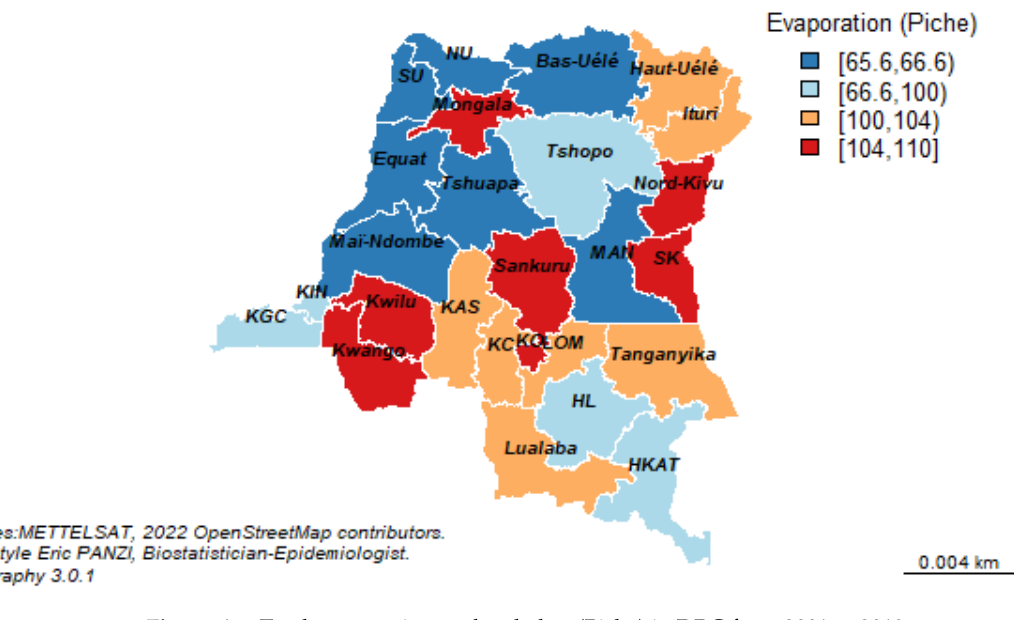
Figure A7. Total evaporation under shelter (Piche) in DRC from 2001 to 2019.